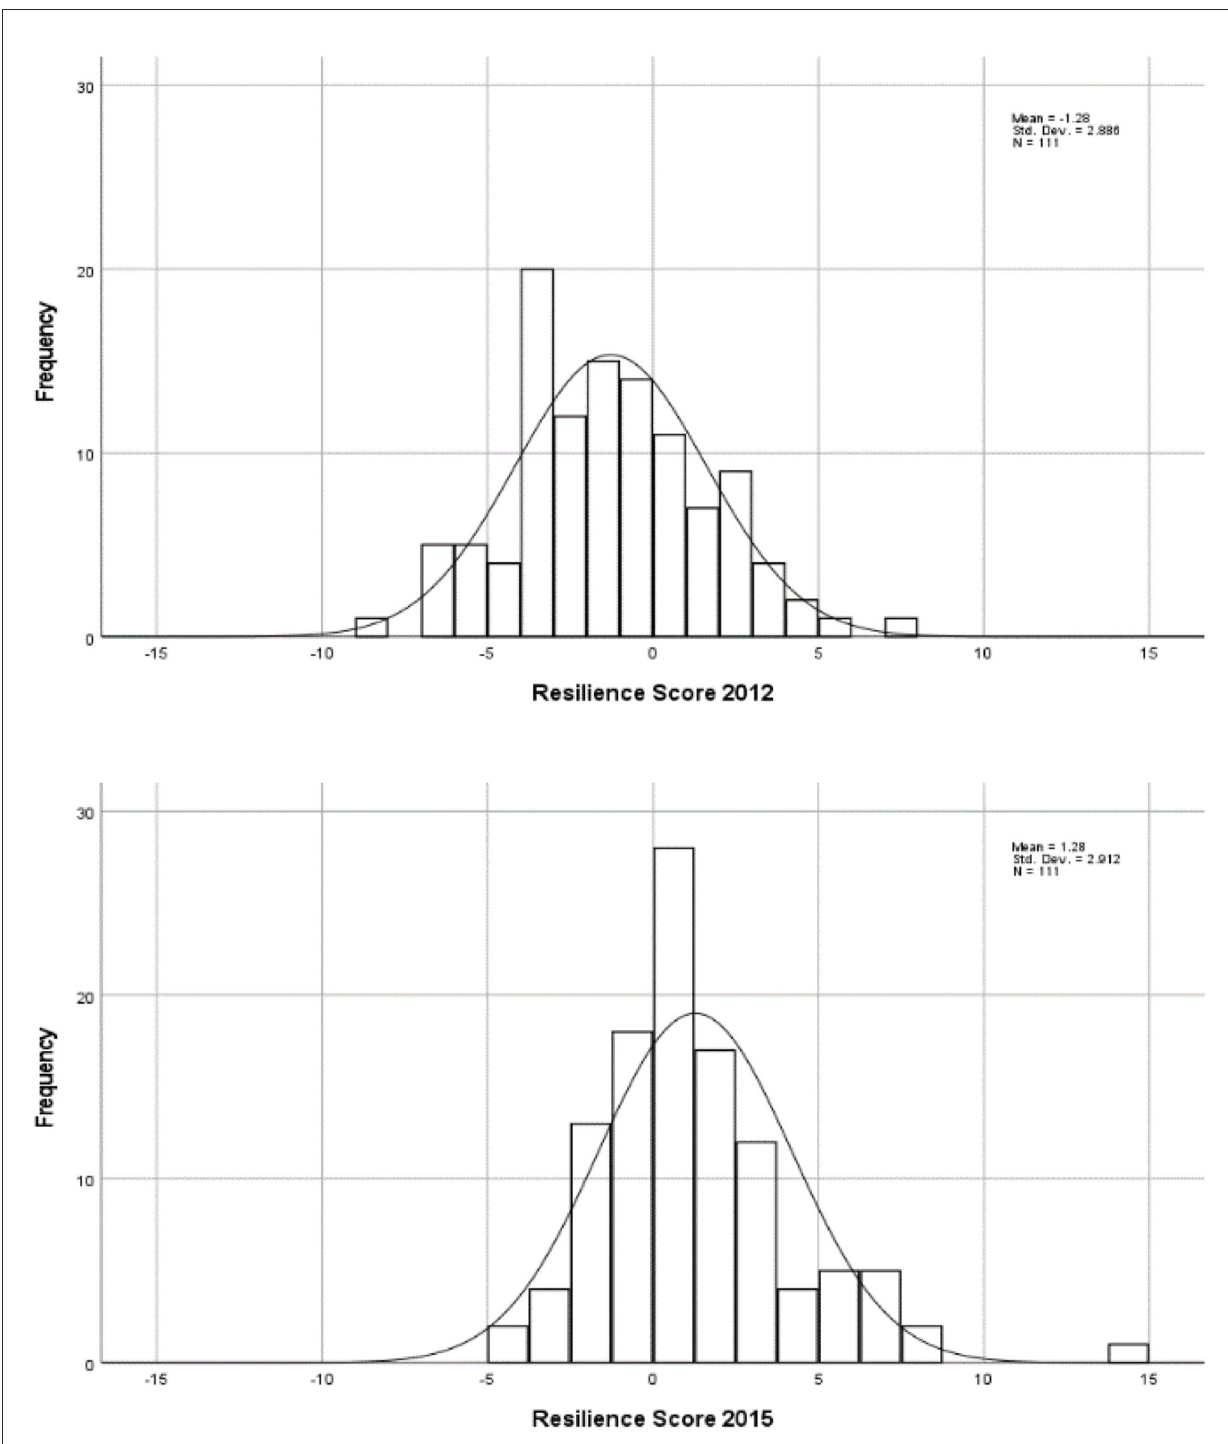
FIGURE5 Distributions of resilience scores in 2012 and 2015. We also observed changes between specific resilience components from 2012 to 2015. The results of the Wilcoxon test showed that the components farming problems, infrastructure, forecasts and actions, and storage facility as well as the resilience score had significantly changed within the period from 2012 to